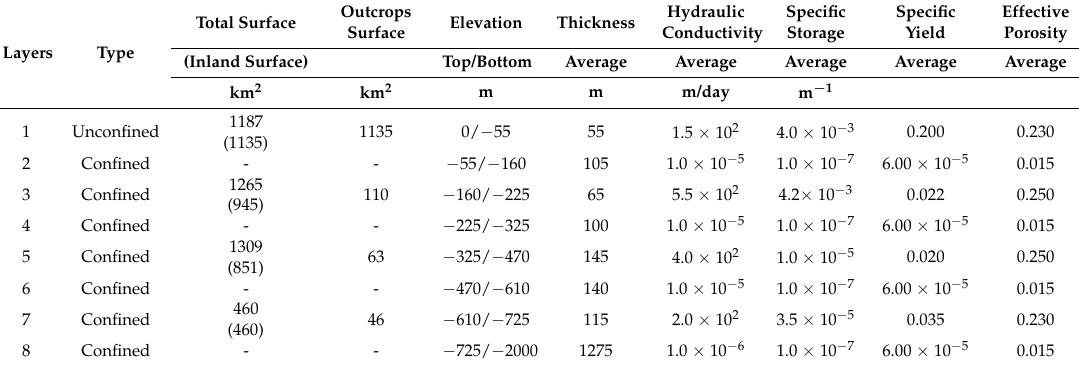
Table 2. Information introduced for numerical modelling of the Campo de Cartagena.